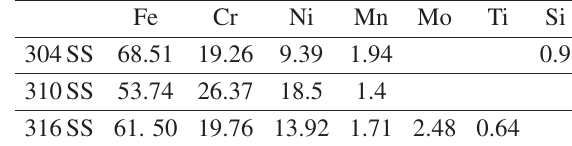
Figure 1. Scale thickness versus time curves for the corro- sion of type 304, 316 and 310 stainless steels in eutectic (Li,Na,K) 2 CO 3 melt at 973 K in